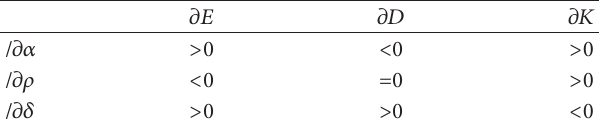
Table 1: The signs of the variations, 𝜕𝐸 / 𝜕𝛼 , 𝜕𝐸 / 𝜕𝜌 , 𝜕𝐸 / 𝜕𝛿 , 𝜕𝐷 / 𝜕𝛼 , 𝜕𝐷 / 𝜕𝛿 , 𝜕𝐾 / 𝜕𝛼 , 𝜕𝐾 / 𝜕𝜌 , and 𝜕𝐾 / 𝜕𝛿 of the functionally relevant parameters 𝐸 , 𝐾 , and 𝐷 , according to variations of the growth-based parameters 𝛼 , 𝜌 , and 𝛿 (according to Section 2).